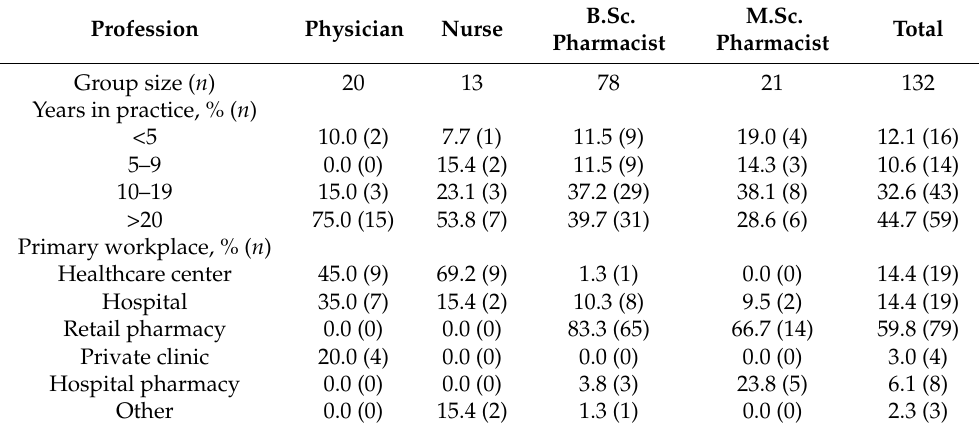
Table 1. Demographics of healthcare professionals.